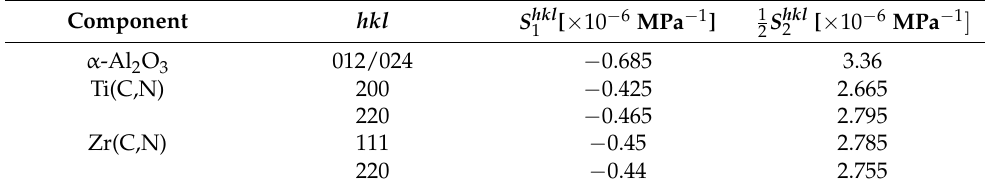
Table 2. DECs for the investigated layers calculated by applying the Eshelby-Kröner model [20,21] using the respective single crystal elastic constants. For the stress evaluation in the Ti(C,N) and Zr(C,N) layers, an average value of the DEC for TiC/TiN and ZrC/ZrN was used, respectively.